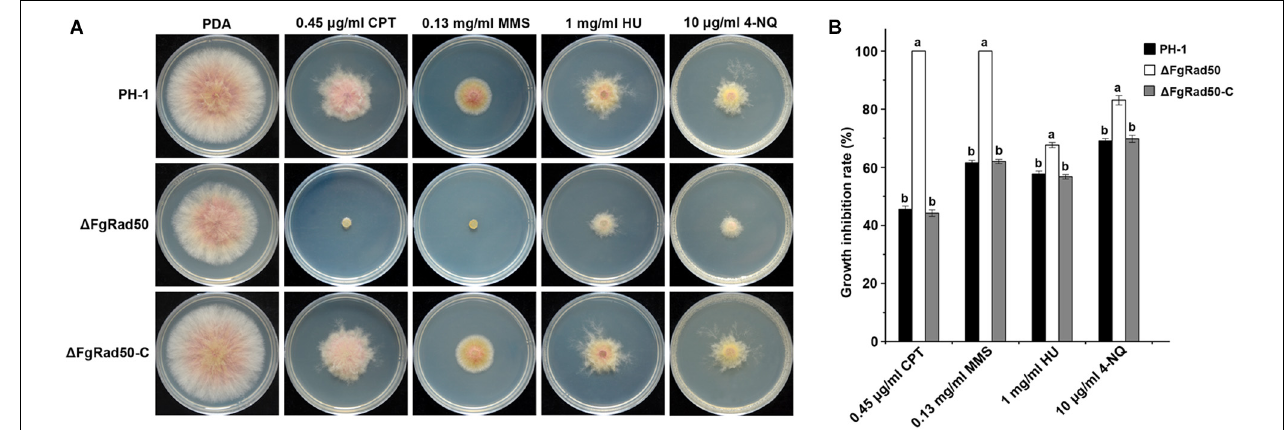
FIGURE 5 | Involvement of FgRad50 in regulating sensitivity to DNA-damaging agents. (A) PH-1, (cid:49) FgRad50 and (cid:49) FgRad50-C inoculated on PDA with or without DNA-damaging agent camptothecin (CPT), methyl methanesulfonate (MMS), hydroxyurea (HU), and 4-nitroquinoline (4-NQ) at various concentrations. (B) Statistical analysis of the growth inhibition rate of PH-1, (cid:49) FgRad50 and (cid:49) FgRad50-C in the presence of the above compounds. Bars in each column denote standard deviations of three experiments. Values on the bars followed by the same letter indicate no significant difference at P = 0.05.